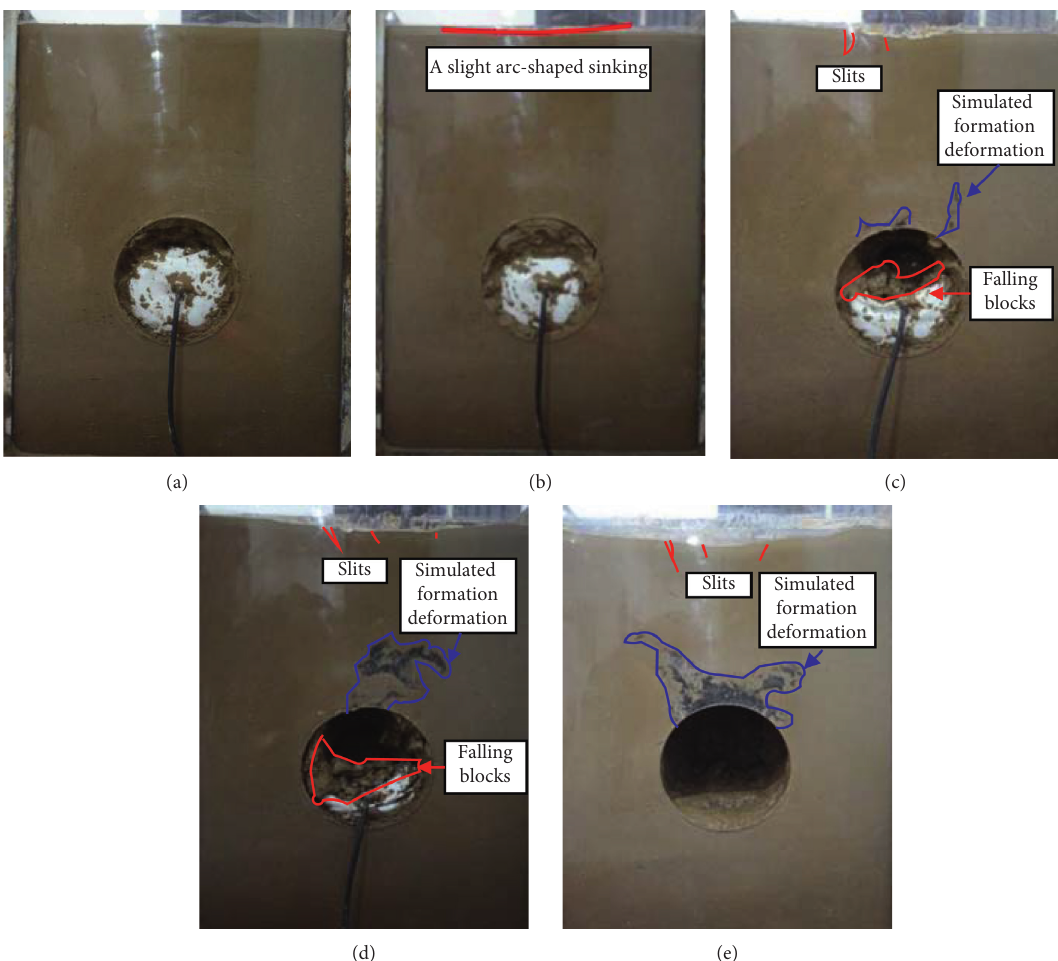
Figure 10: Instability evolution process of stratum without cavity. (a) P � 0MPa. (b) P � 0.02 MPa. (c) P � 0.04MPa. (d) P � 0.06MPa. (e) P �